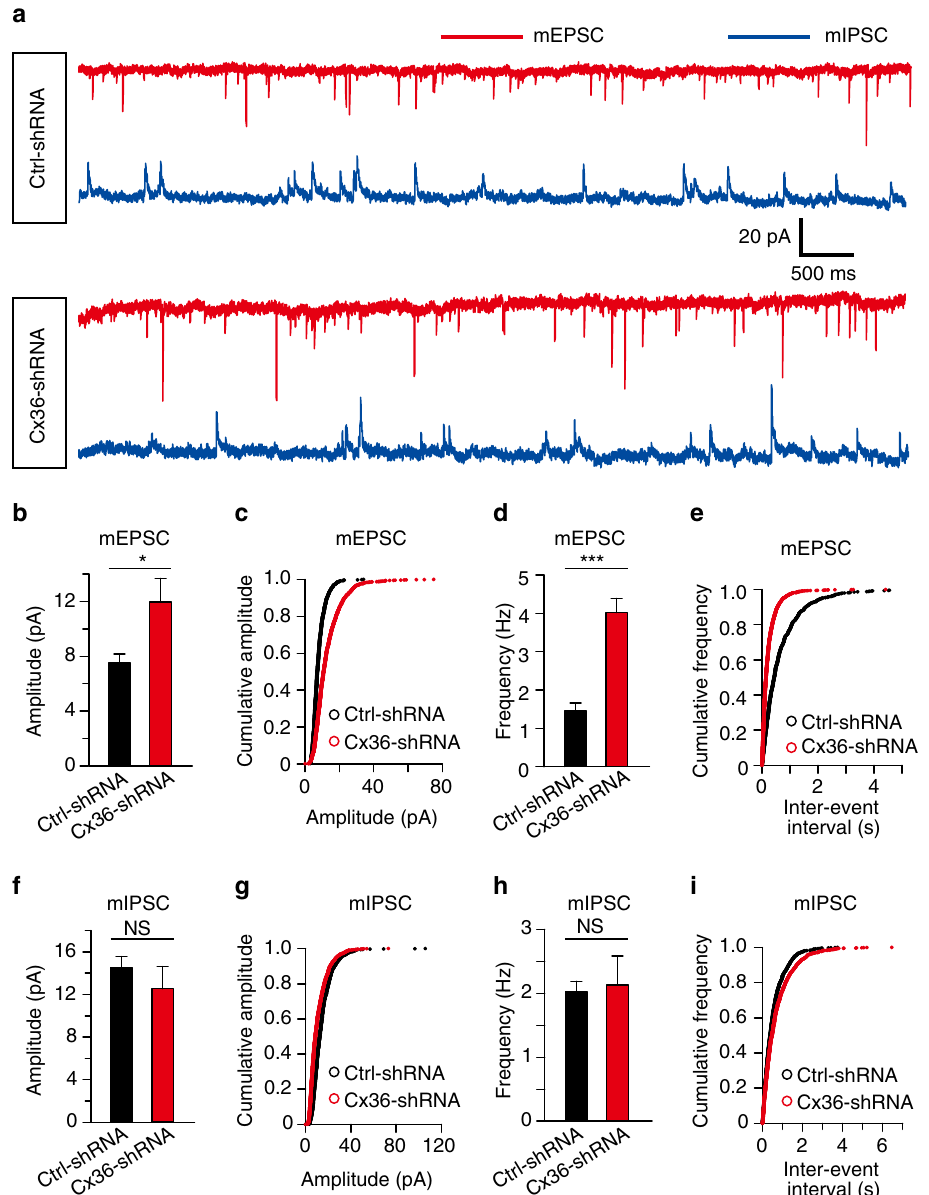
Figure 9 | Modulation of miniature postsynaptic currents by electrical coupling in neocortical layer 1. ( a ) Representative traces of inward mEPSCs (red traces, holding potential of (cid:2) 60mV) and outward mIPSCs (blue traces, holding potential of þ 10mV) recorded in Ctrl-shRNA and Cx36-shRNA groups in the presence of tetrodotoxin (5 m M). ( b – e ) Histograms ( b , d ) and cumulative distributions ( c , e ) of mEPSC amplitudes ( b , c ) and frequencies ( d , e ). Both the peak amplitude and frequency of mEPSCs in Cx36-shRNA group were significantly higher than those in Ctrl-shRNA group. ( f – i ) Histograms ( f , h ) and cumulative distributions ( g , i ) of mIPSC amplitudes ( f , g ) and frequencies ( h , i ). The peak amplitude and frequency of mIPSCs showed no significant differences between Cx36-shRNA and Ctrl-shRNA groups ( n ¼ 12 in Cx36-shRNA group, n ¼ 8 in Ctrl-shRNA group, three mice for each group). * P o 0.05, *** P o 0.001, n.s., P 4 0.05, not significant. Two-tailed paired t -test. Error bars represent mean ±